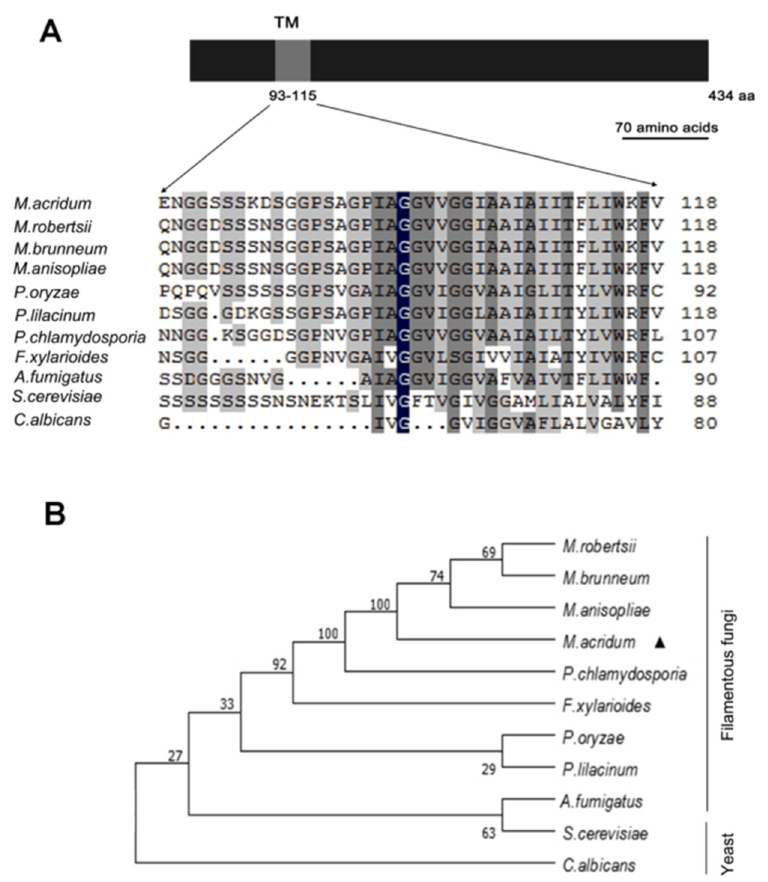
Figure 1. Characterization of MaOpy2 and the phenotypic tree construction. ( A ) Conserved TM domain in Opy2. ( B ) The phenotypic tree was constructed with the Opy2 protein sequences of Metarhizium acridum (XP_007810157.1), Metarhizium anisopliae (KFG88145.1), Metarhizium robertsii (XP_007819189.1), Metarhizium brunneum (XP_014545484.1), Pochonia chlamydosporia (XP_018139580.1), Fusarium xylarioides (KAG5792966.1), Aspergillus fumigatus (KAF4287340.1), Saccharomyces cerevisiae (CAD6650216.1), Pyricularia oryzae (KAH8847656.1), Candida albicans (CAA21990.1) and Paecilomyces lilacinus